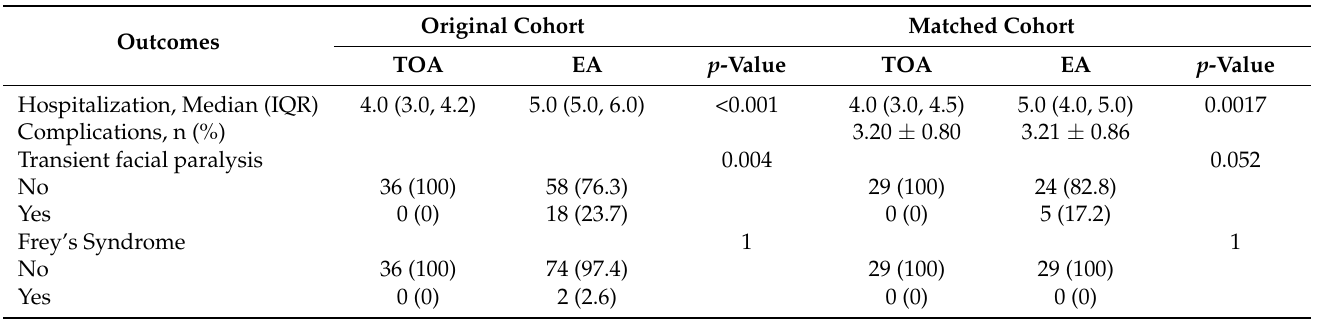
Table 4. The total hospital stays and complications of the transoral approach and external approach groups before and after